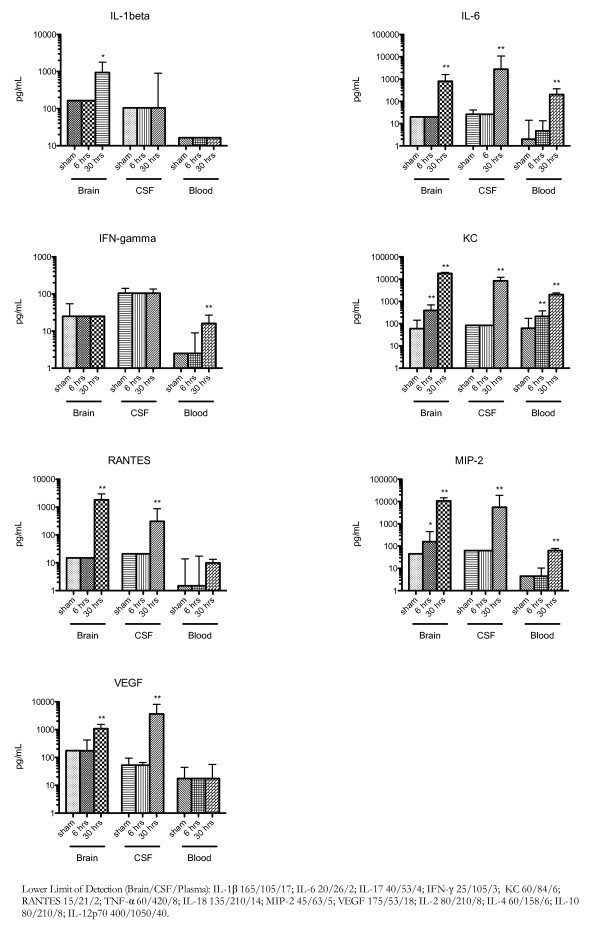
Cytokine levels in plasma, brain homogenates and CSF. Median concentrations (expressed in pg/ml) of cytokines in mice inoculated with either NaCl or 104 CFU/mouse of S. pneumoniae and sacrificed after 30 hours, or 6 and 30 hours respectively. Comparisons of cytokine levels between groups were calculated using the Mann-Whitney U test. (*P < 0.05; **P < 0.01).